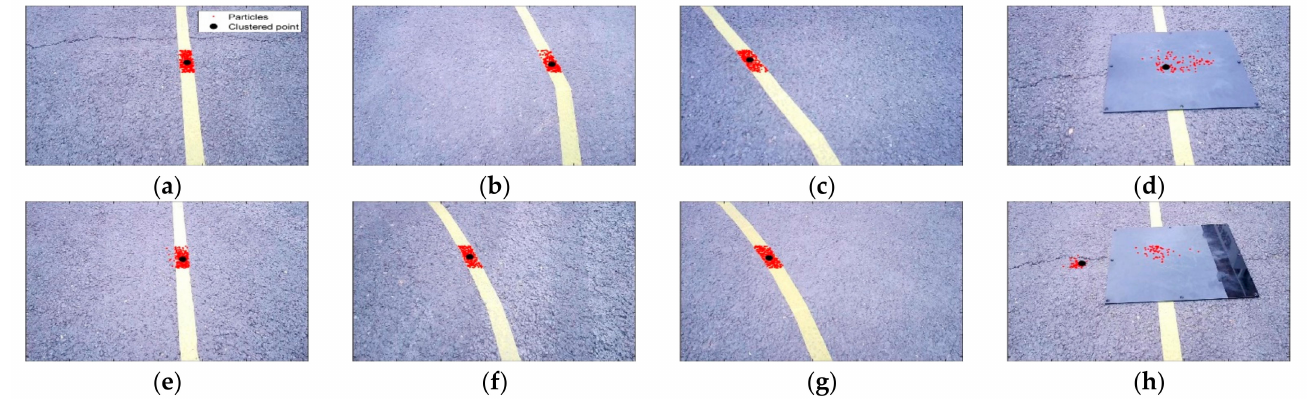
Figure 11. ( a ) Actual experiment image—60th frame; ( b ) actual experiment image—120th frame; ( c ) actual experiment image—180th frame; ( d ) actual experiment image—252nd frame; ( e ) actual experiment image—320th frame; ( f ) actual experiment image—380th frame; ( g ) actual experiment image—430th frame; ( h ) actual experiment image—509th